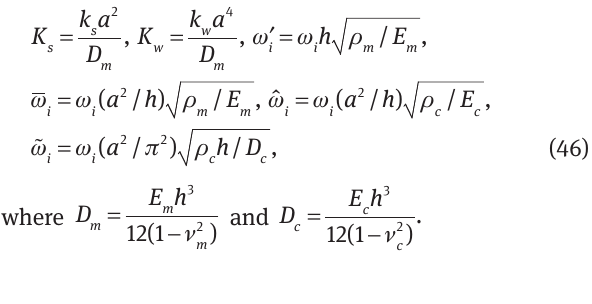
ω of simply supported FG plates ( K 1